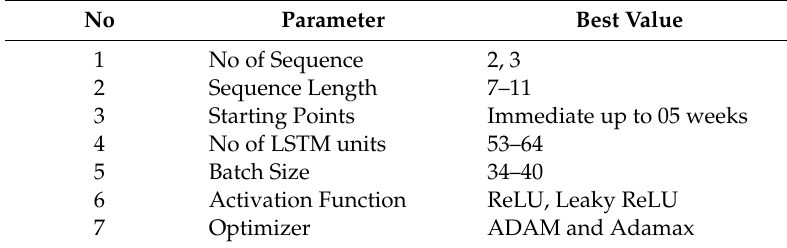
Table 3. Optimal parameters found by the metaheuristics